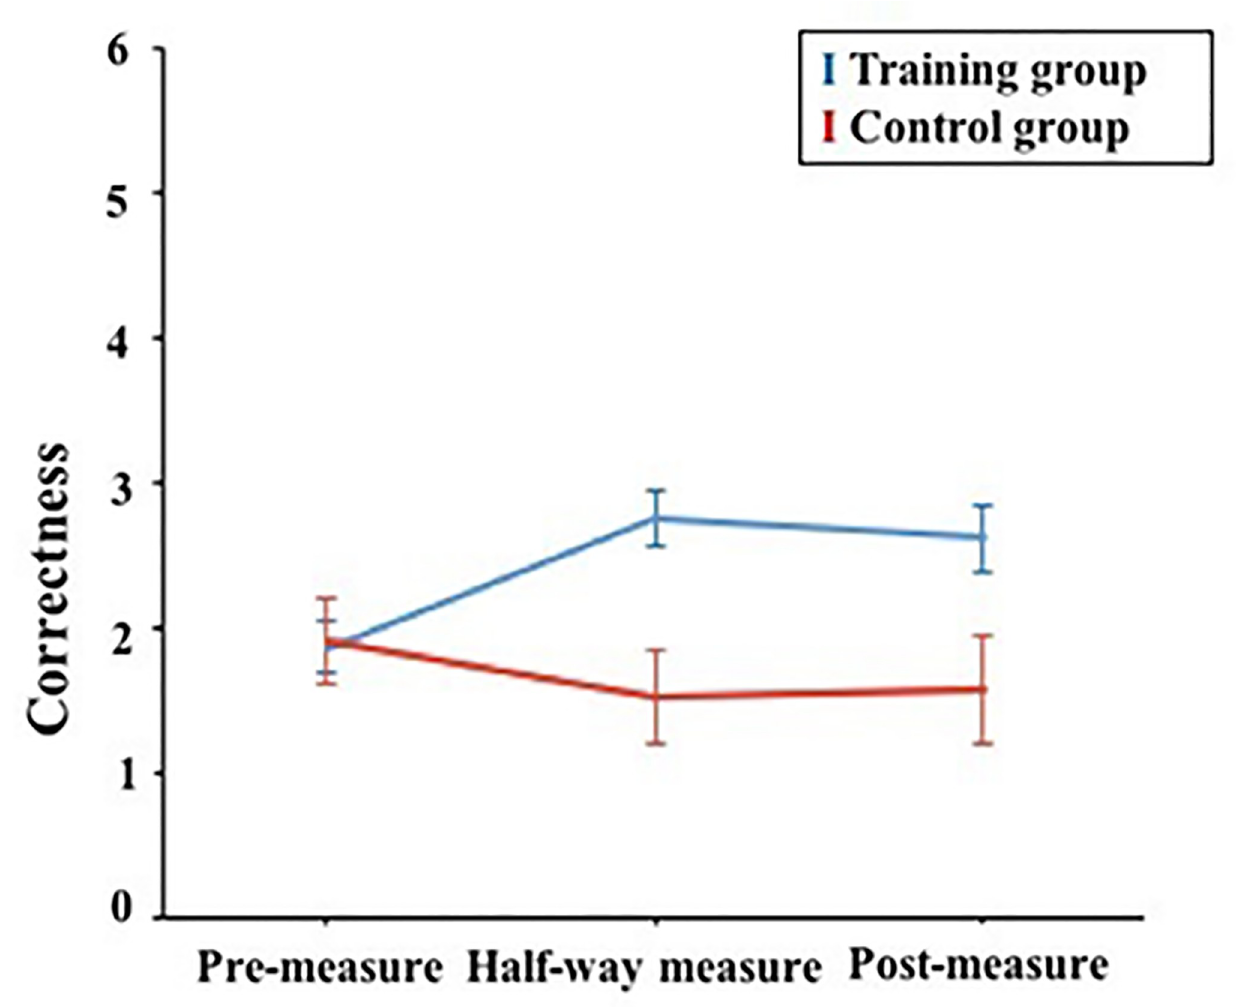
Fig 3. Effects of the creativity training on RAT as function of treatment and measurement time.